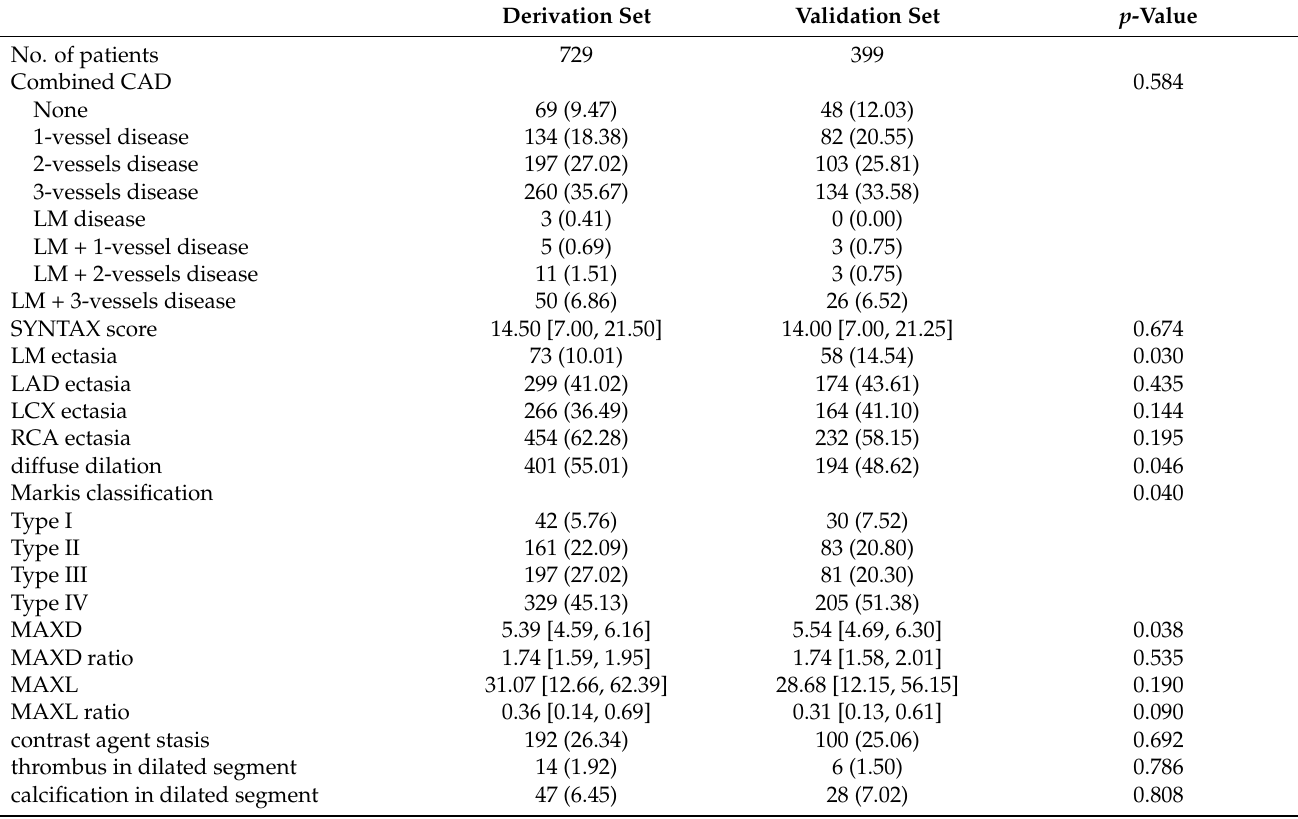
Table 2. Coronary angiography evaluation of the derivation dataset and validation